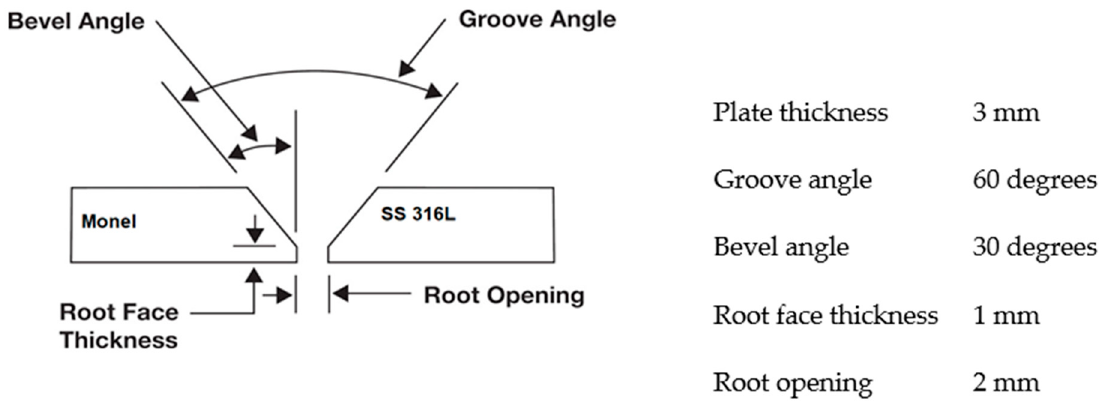
Figure 1. Weld-groove configuration and sizes.